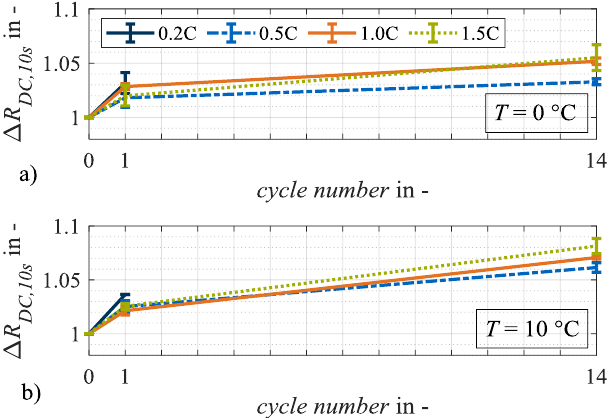
Figure 6. Relative changes in resistance Δ R DC, 10s at test points with charge rates of 0.2C, 0.5C, 1.0C and 1.5C after load cycles 1 and 14 at ( a ) 0 °C and ( b ) 10 °C. The error bars show the result deviation from